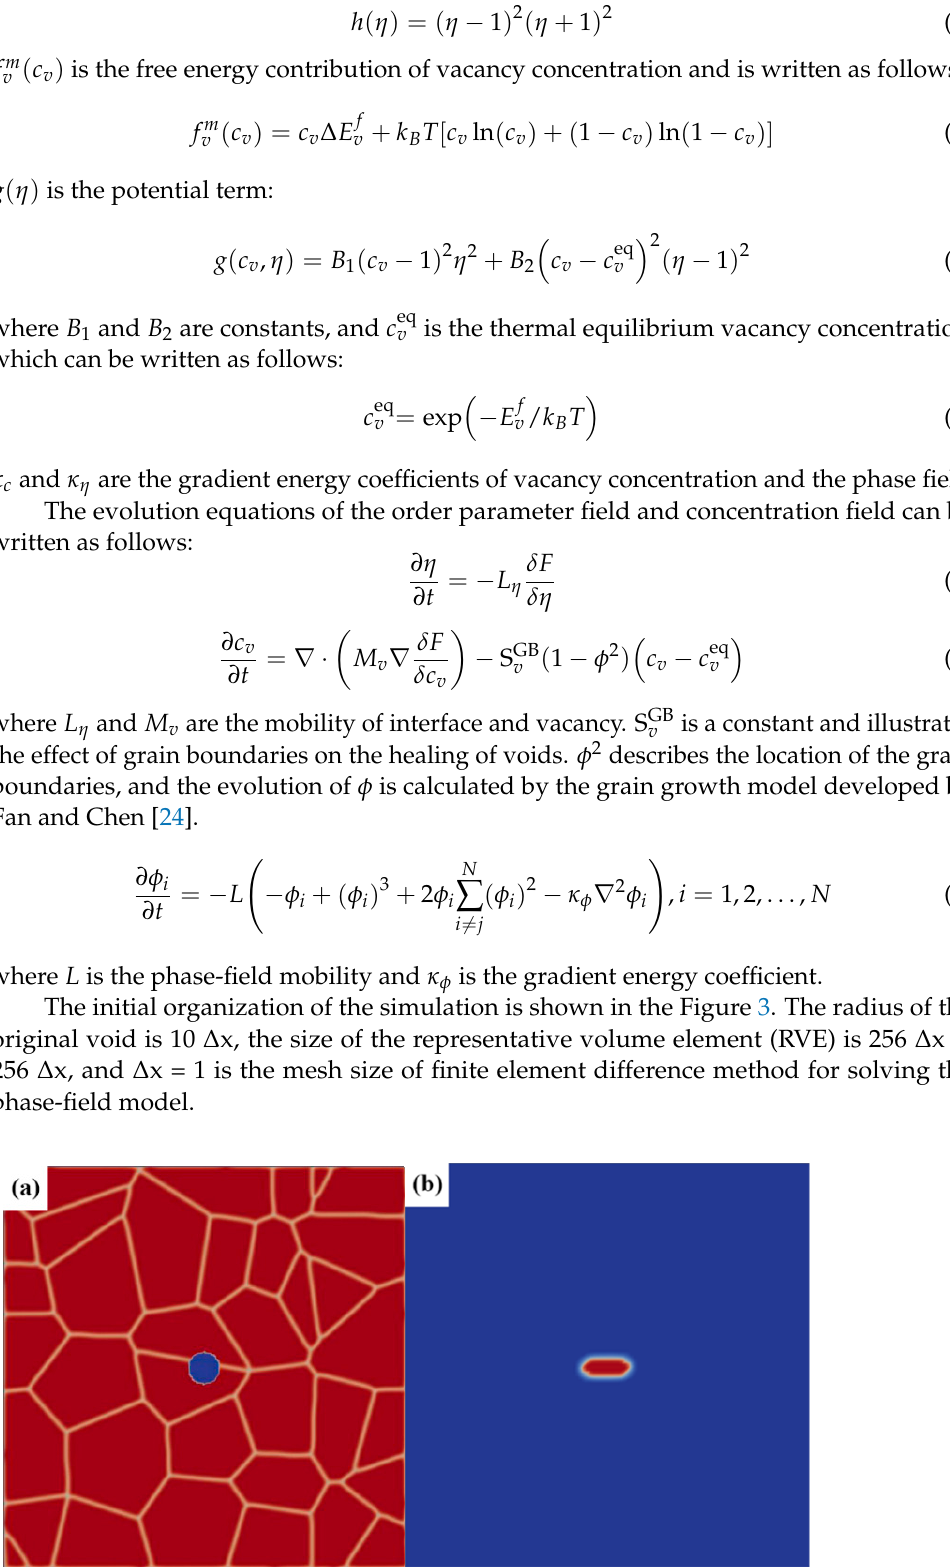
Figure 3. Initial organization of the phase-field method (PFM) simulation: ( a ) the grain-size effect; ( b ) the void-shape effect.